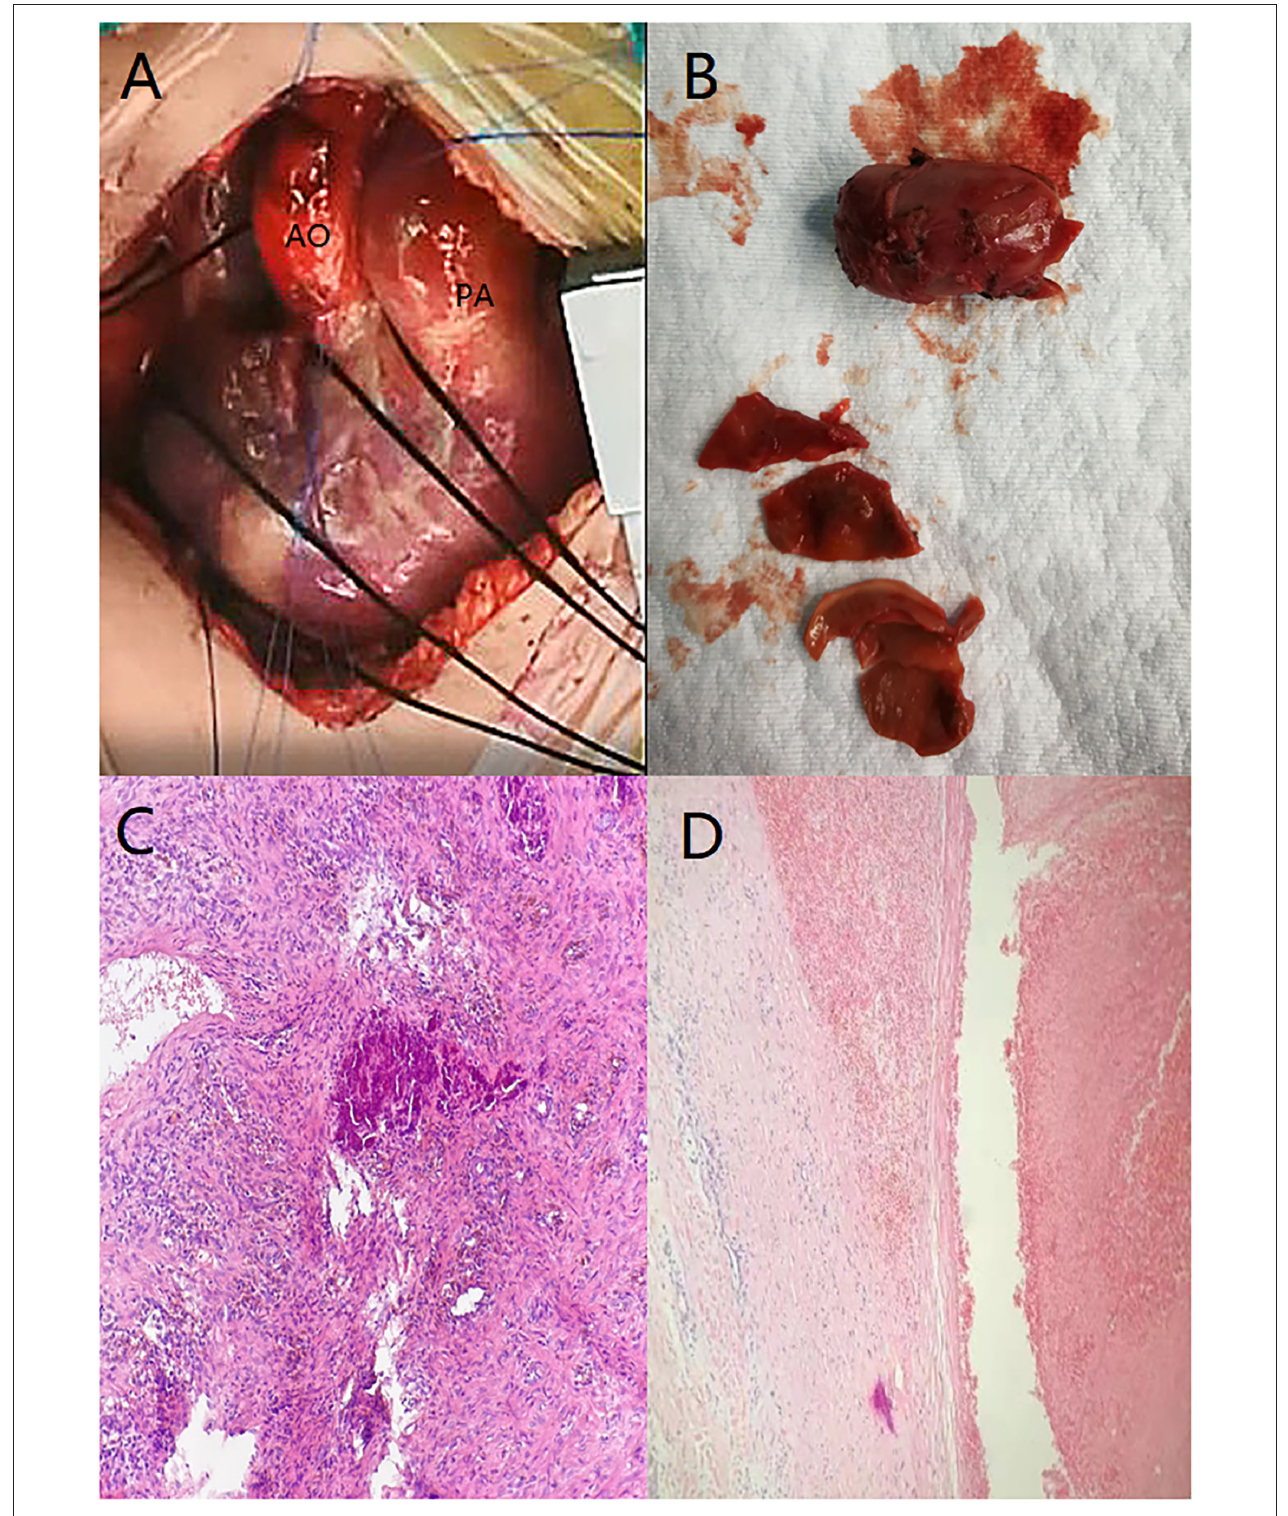
FIGURE 3 | (A) Anterior wall of the trunk of the pulmonary artery was enlarged. (B) Thrombus-like tissue was removed during the operation, the color is darker, and the blood vessel wall is visible. (C) Visible dark calcification and surrounding brown-yellow hemosiderin changes. (D) Static image shows that the membrane is separating.